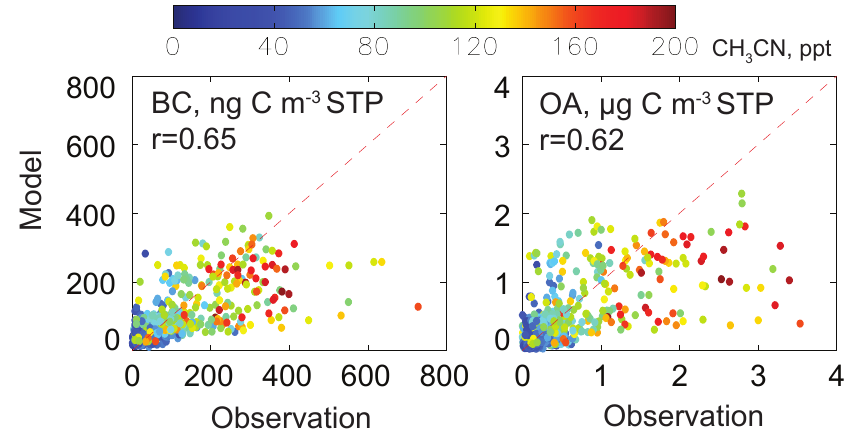
Fig. 6. Scatterplots of simulated vs. observed BC and OA concentrations along the DC-8 flight tracks during ARCTAS (1–19 April 2008). Colors indicate the corresponding concentrations of CH 3 CN, a tracer of biomass burning. The 1:1 line is also shown.